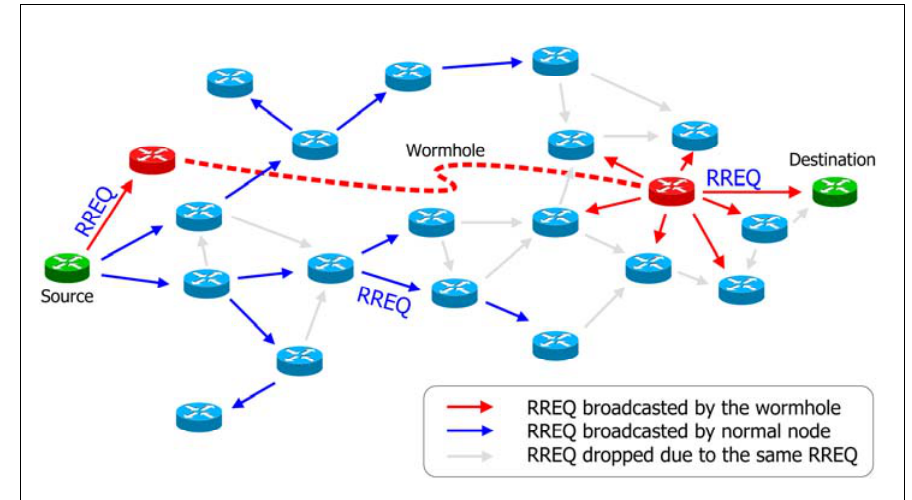
Figure 5. Route establishment under the wormhole